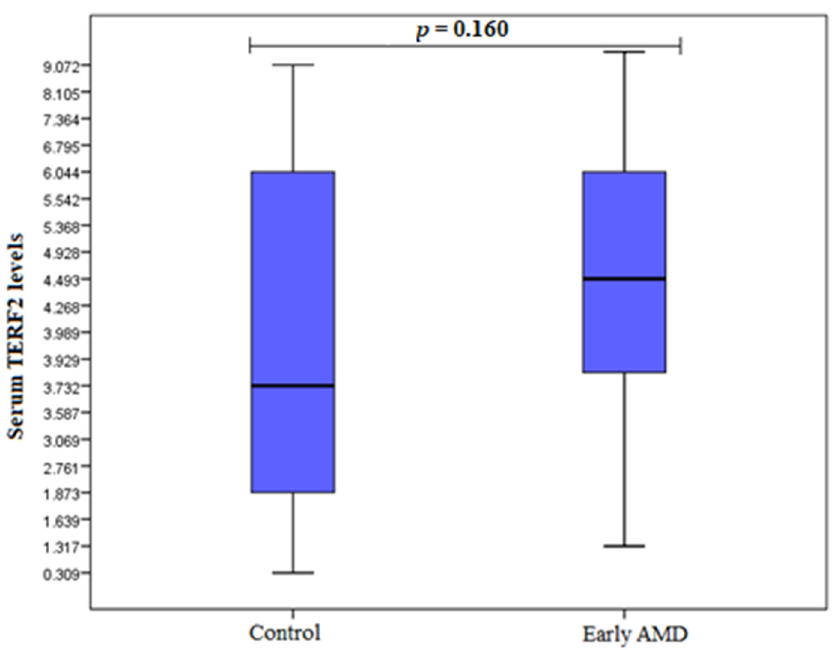
Figure 6. Serum levels of TERF2 in patients with early AMD and control group. AMD: age-related macular degeneration; Serum protein values are presented as median and IQR. Mann–Whitney U test was used to assess serum TERF2 levels differences between patients with early AMD and control groups; p = 0.160.